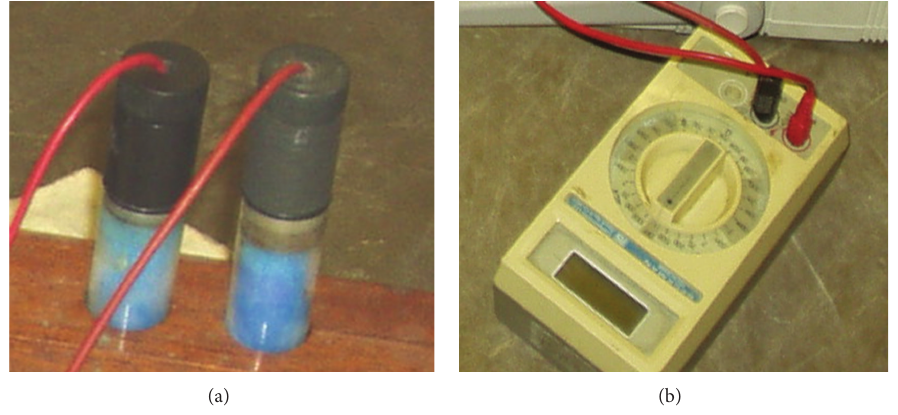
Figure 4: Half-cell potential measurements: (a) copper/copper sulphate electrode and (b) digital voltmeter.